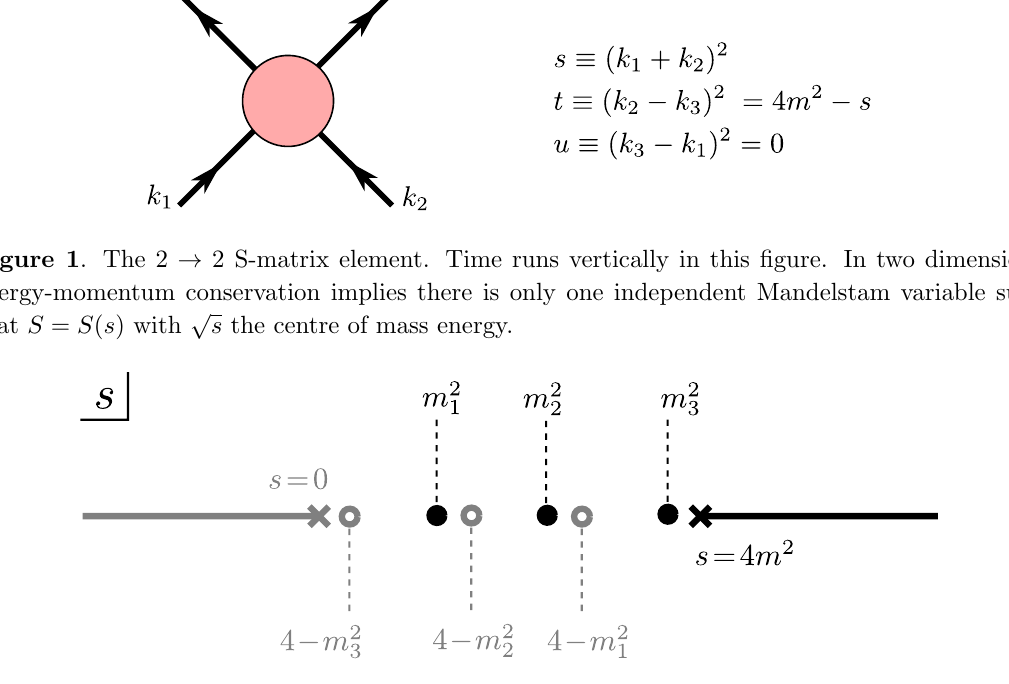
Figure 2 . Analytic properties of the S-matrix element S ( s ) for the scattering of the lightest particles of the theory. We have a cut starting at s = 4 m 2 corresponding to the two particle production threshold. As implied by (2.1), we have another cut starting at t = 4 m 2 (or s = 0) describing particle production in the t -channel process. The segment s [0 ; 4 m 2 ] between the two 2 particle cuts is where most of the action takes place for us. It is here that poles corresponding to fundamental particles or their bound-states can appear as in (2.3). We distinguish s and t channel poles (solid and empty circles respectively) by the sign of their residues. When the external particles are not the lightest in the theory, we sometimes have more singularities such as further two particle cuts and/or Coleman-Thun